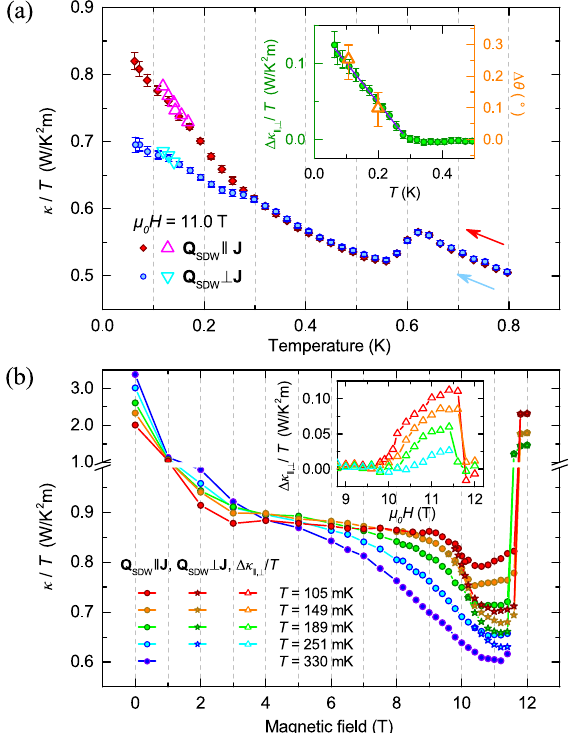
FIG. 2. (a) Temperature dependence of the thermal conductivity ⊥ J (blue symbols), and over T ( κ =T ) for θ ¼ 44 . 7 ° when Q SDW ∥ J (red symbols) at a fixed field. The for θ ¼ 45 . 7 ° when Q SDW step at 0.6 K reflects the superconducting – normal transition. The data with higher thermal gradients (cyan and magenta triangles) show no difference from the other data ( Δ T=T ≈ 0 . 06 ); i.e., there are no indications of the sliding mode of the SDW (Appendix D). Inset: The difference ( Δ κ ∥ ; ⊥ =T ) between κ =T for the two (green circles, left axis) and the width of orientations of Q SDW the hysteresis Δ θ (from Fig. 6) at two temperatures for μ ¼ 11 T (orange triangles, right axis). The onset temperature 0 H of the Q phase at μ 0 H ¼ 11 T is depicted as a diamond on the phase diagram in Fig. 1(a). (b) Magnetic-field dependence of the thermal conductivity over T ( κ =T ) at several temperatures. The field directions for the two different Q orientations are SDW the same as in (a). The inset shows the difference between κ =T for the two orientations. The onset of the rise in Δ κ ∥ ; ⊥ =T is taken as a Q -phase transition and is displayed as red circles in Fig.